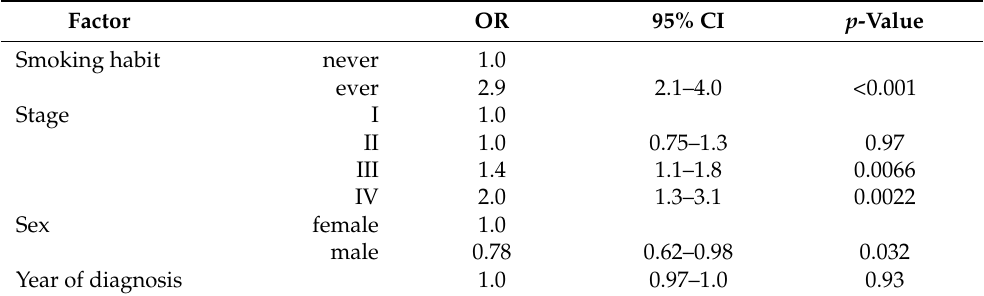
Table 5. Results of the logistic regression with age at diagnosis, smoking habit, pathological stage, sex, and year of diagnosis in the validation